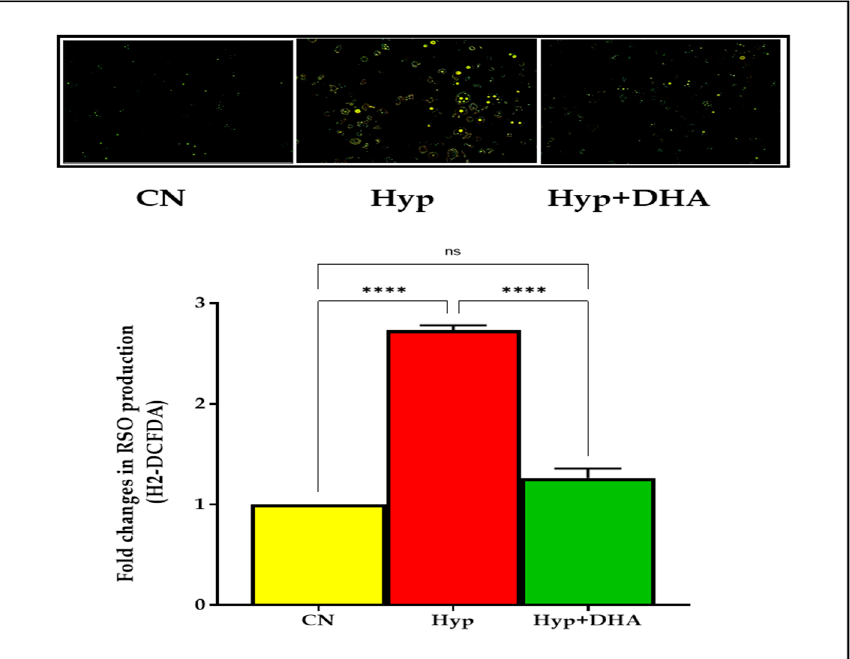
Figure 3. Photograph of ROS immunofluorescence spots expression using carboxy-H2DCFDA dye. 3T3-L1 adipocytes (7–10 days post-differentiation) were subjected to normoxia, hypoxia (1% O2), and hypoxia (1% O2) supplemented with DHA (50nM) for 24 h. They were analyzed for ROS production determined by the immunofluorescence of H2DCFDA dye ( A ); see Methods section. Data represent 3–5 independent experiments. Bars show the data presented as means ± SD of 3–4 independent experiments analyzed by one-way ANOVA and posthoc multiple comparison Tukey tests ( B ). Two-tailed p-value is significant for p < 0.05. **** p < 0.0001; ns = not significant.